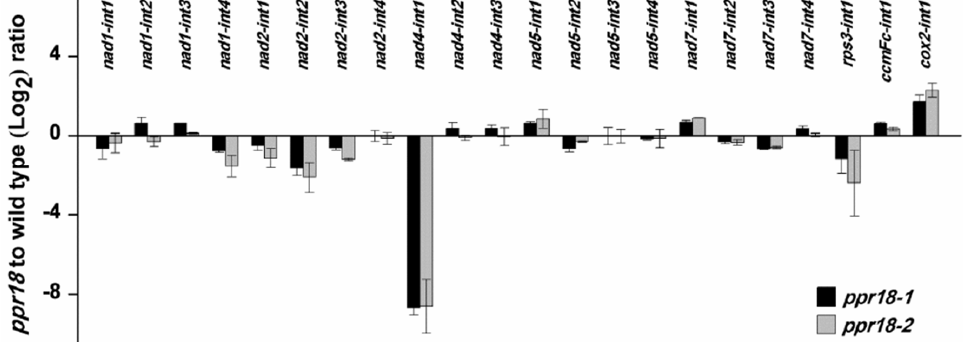
Figure 7. Splicing efficiency of mitochondrial introns in ppr18 mutants. qRT-PCR analysis of the splicing efficiency of all 22 group II introns of maize mitochondrial genes in ppr18 mutants. The ratio of spliced to unspliced fragments was used to measure splicing efficiency. Data are means (± SE) of three biological replicates.